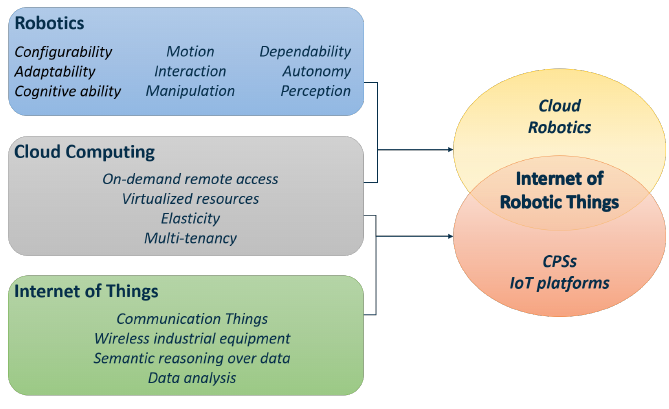
Figure 1. Highlights of Robotics, Cloud Computing and Internet of Things, which merge into the Internet of Robotic